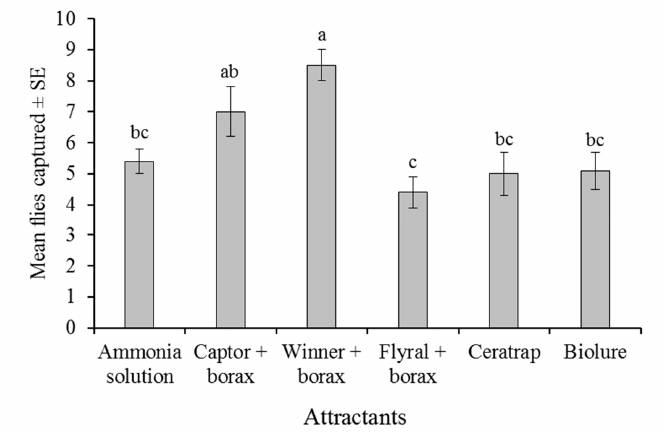
Figure 2. Mean numbers of A. obliqua flies captured in traps baited with the 150 mM ammonia solution or five different commercial attractants under a six-way laboratory choice experiment. Columns headed by the same letter do not differ significantly (ANOVA, Tukey, p > 0.05). The mean percentage of females captured varied between 39.5 ± 4.9% for CeraTrap and 51.0 ± 3.8% for the 150 mM ammonia solution but did not vary significantly among attractants (F = 3.819, df = 1, 240, p = 0.052; data not shown in Figure 2). There was no significant correlation between the number of flies captured and the quantity of gaseous ammonia released by the attractants (determined previously in Table 1; Spearman’s rho = 0.4857, p = 0.50).